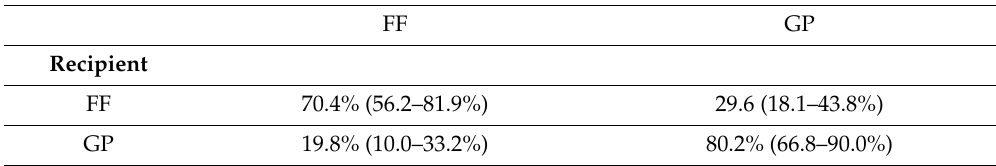
Table 3. Phylogenetically estimated sources of HIV-1 acquisition among FF and GP study participants. Estimated sources of infection among study participants, based on